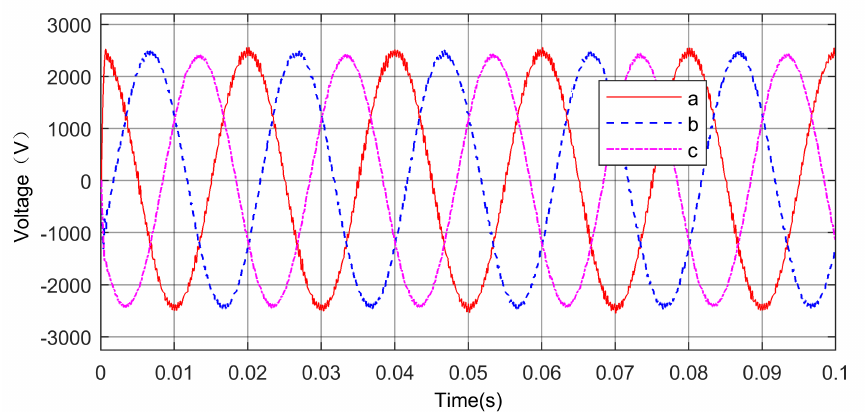
Figure 10. Output three-phase voltage diagram under case 2.